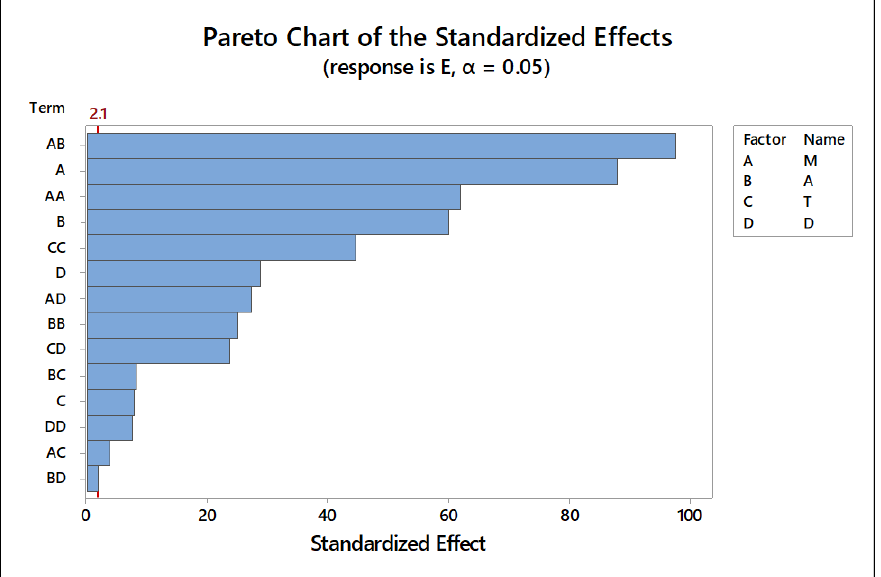
Figure 25. Pareto chart showing the relative significance level of each of the parameters of the esterification of WCO.